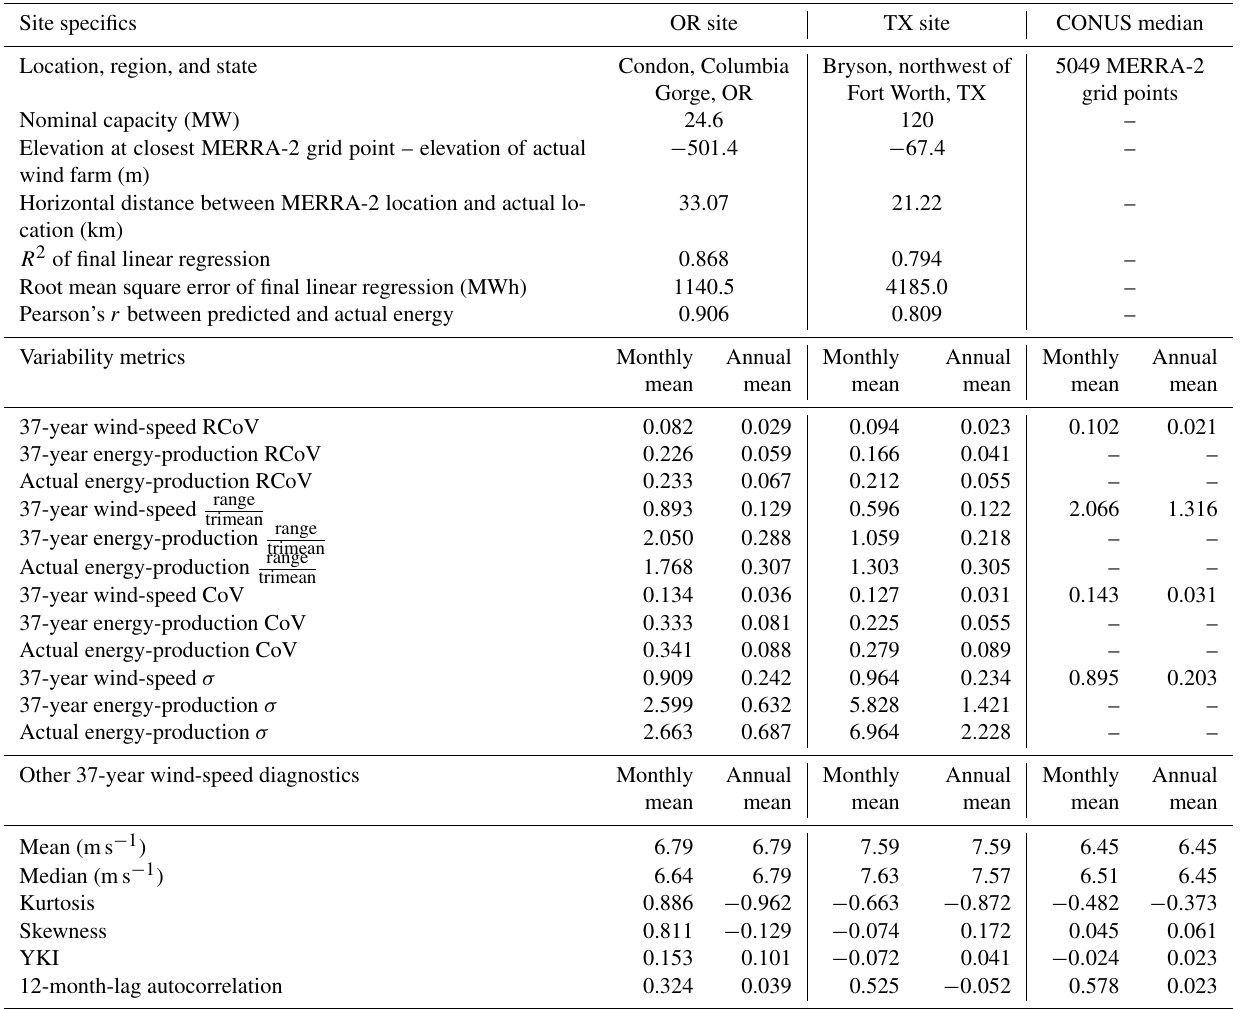
Table 2. Site details, monthly means, and annual means of various metrics at the two selected sites based on 37 years of monthly and annual wind speeds, and 37 years of predicted and actual energy production; and the CONUS medians of wind-speed metrics using 37 years of monthly and annual-mean